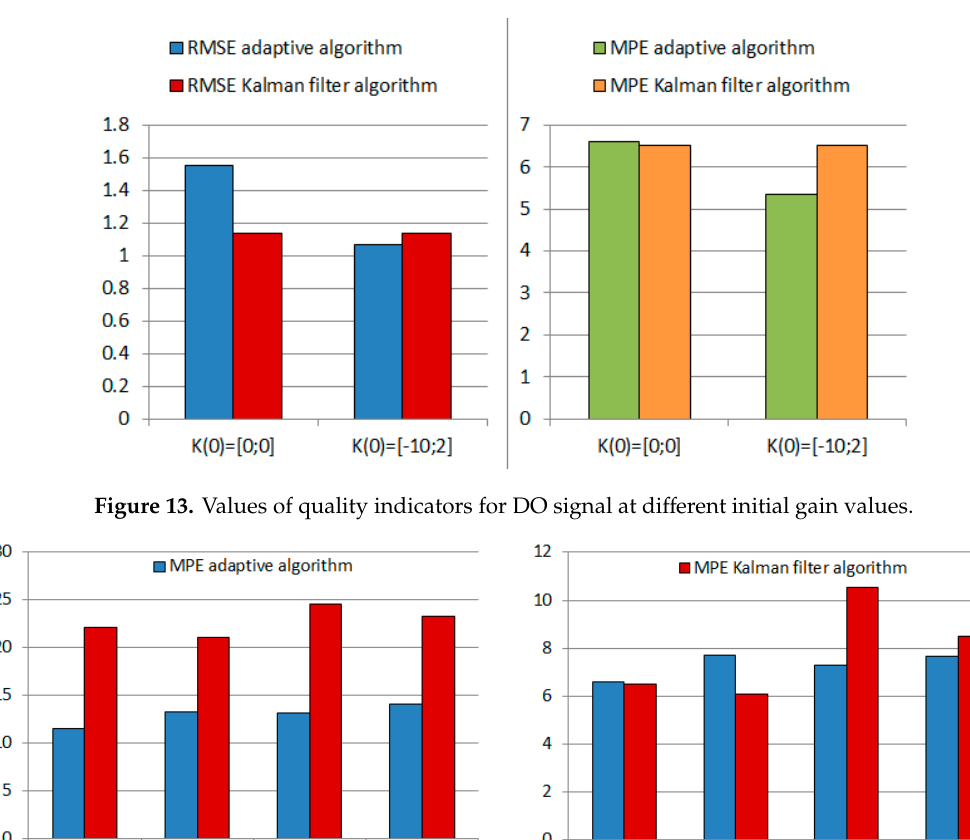
Figure 12. Root-mean-squared error (RMSE) quality indicators BOD ( a ) and DO ( b ) signals generated.